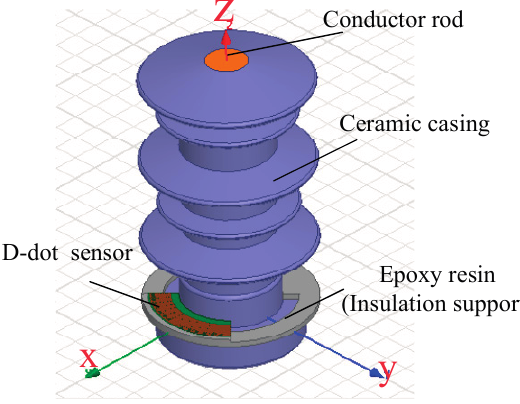
Figure 4. Finite element analysis model.